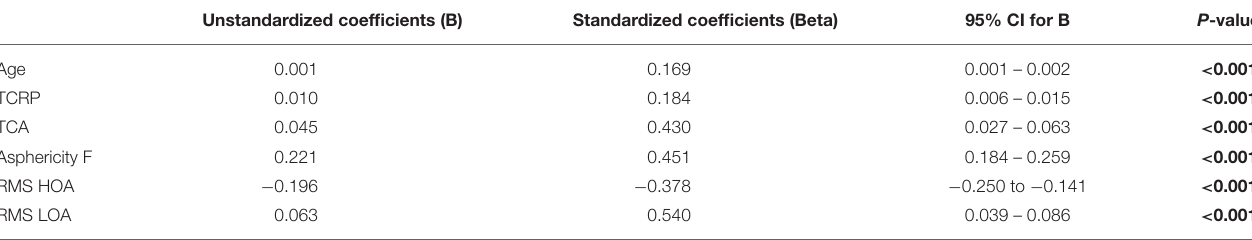
TABLE 4 | Multiple linear regression analysis of factors associated with total corneal spherical aberration in patients with bilateral ectopia